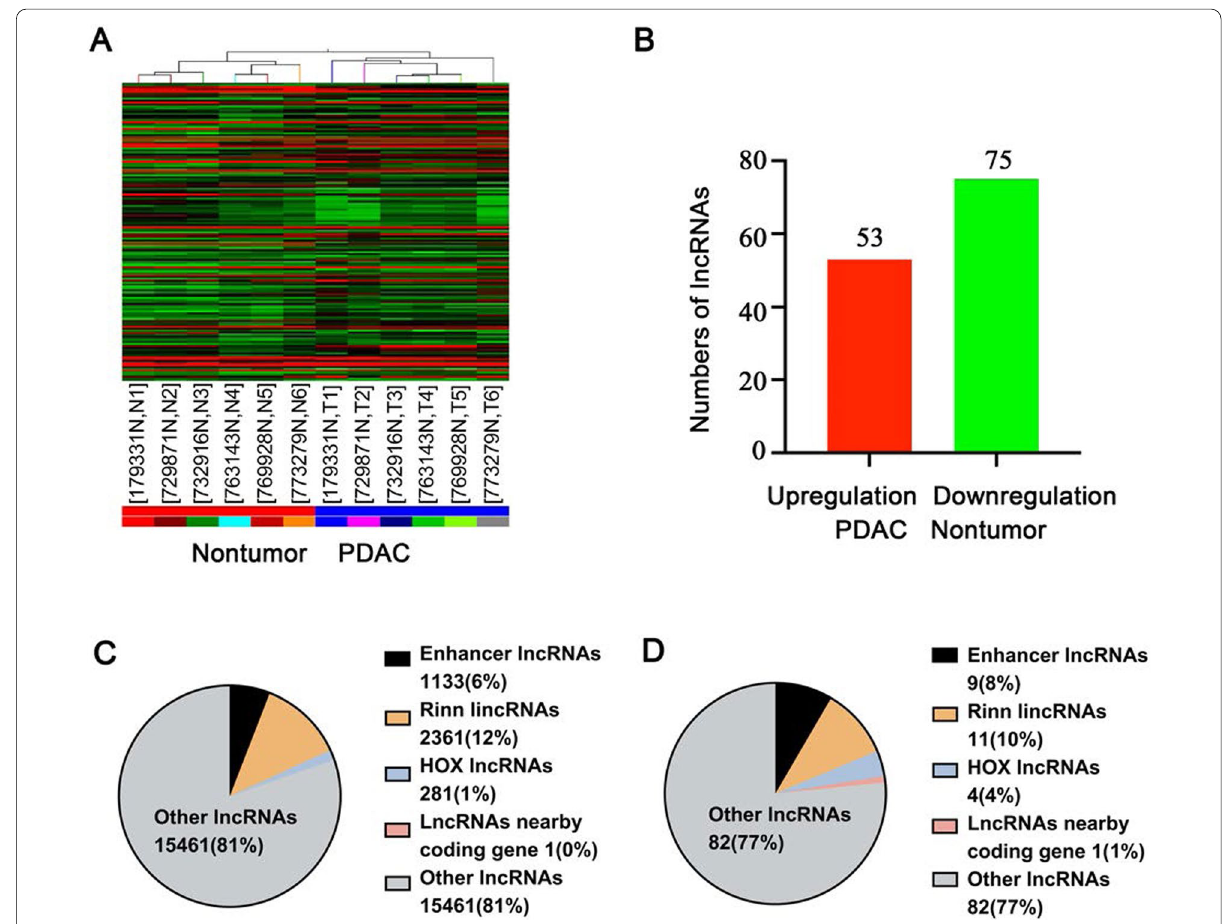
Fig. 1 Microarray analysis of differentially expressed lncRNAs between six pancreatic ductal adenocarcinoma (T) samples and paired non-tumor (N) samples. A Hierarchical cluster analysis of differentially expressed ( twofold change) lncRNAs between six pancreatic ductal adenocarcinoma ≥ (T) samples and paired nontumor (N) samples. The red color indicates upregulation, while the green color indicates downregulation. B A total of 128 lncRNAs, with the upregulation of 53 lncRNAs and downregulation of 75 lncRNAs, were selected for clustering. C Classifications of detected lncRNAs in pancreatic ductal adenocarcinoma samples. D Classifications of significantly differentially expressed lncRNAs between pancreatic ductal adenocarcinoma samples and paired nontumor